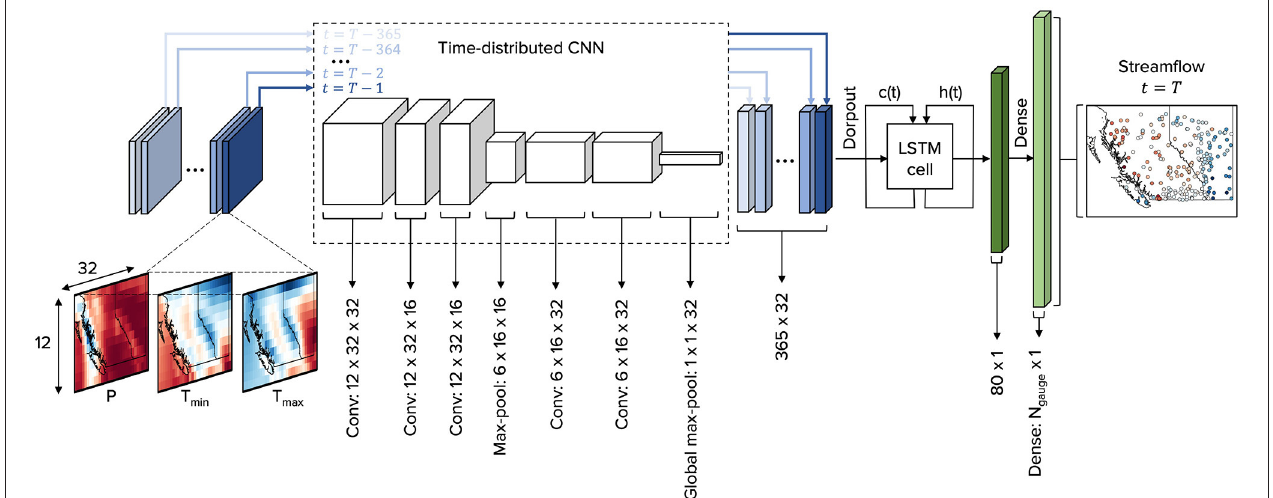
FIGURE 3 | Schematic of the CNN-LSTM architecture. T max ( x , y , t ), T min ( x , y , t ), and P ( x , y , t ) from T − 365 ≤ t ≤ T − 1 are input frame-wise through a time-distributed CNN, creating a series of 365 feature vectors each with length 32, where t is time (day) and T is the day of streamflow being predicted. The series of feature vectors is input to an LSTM with 80 units. c ( t ) and h ( t ) are the cell and hidden states, respectively. The output of the LSTM is h ( t = T − 1), which is passed through a final dense layer with linear activation to predict streamflow at N gauge stations at time t = T . N gauge is the number of stream gauge stations being predicted by the model, and depends on the stream gauge